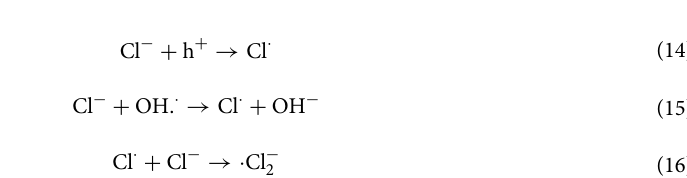
Figure 18. ( a ) Degradation profile and ( b ) kinetics plot in an environment of selected cations, and ( c ) Degradation profile and ( d ) kinetics plot in an environment of selected anions for MG dye degradation using photocatalyst